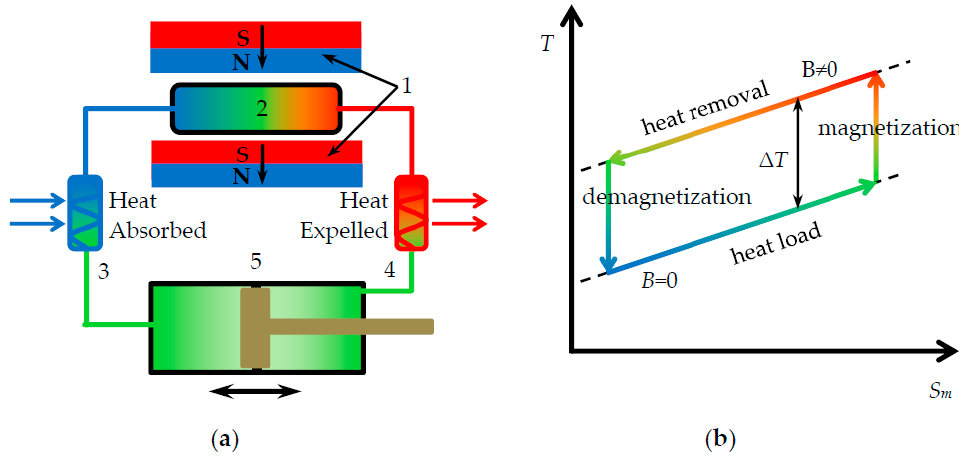
Figure 1. Schematic of the refrigerator with AMR ( a ), temperature ( T ) vs. entropy ( S m ) diagram of the AMR cycle ( b ); (1) magnets or poles of an electromagnet, (2) regenerator with MCM, (3) cold heat exchanger, (4) hot heat exchanger, and (5) piston pump.